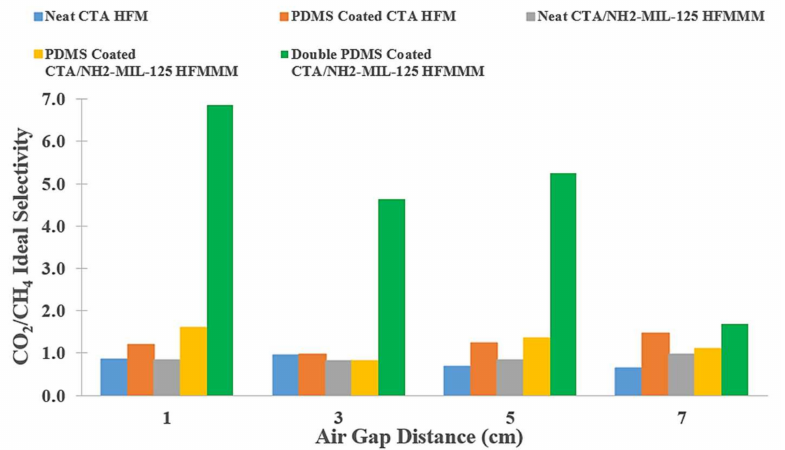
Figure 8. CO 2 /CH 4 gas pair ideal selectivity for the fabricated fibers at various air gap